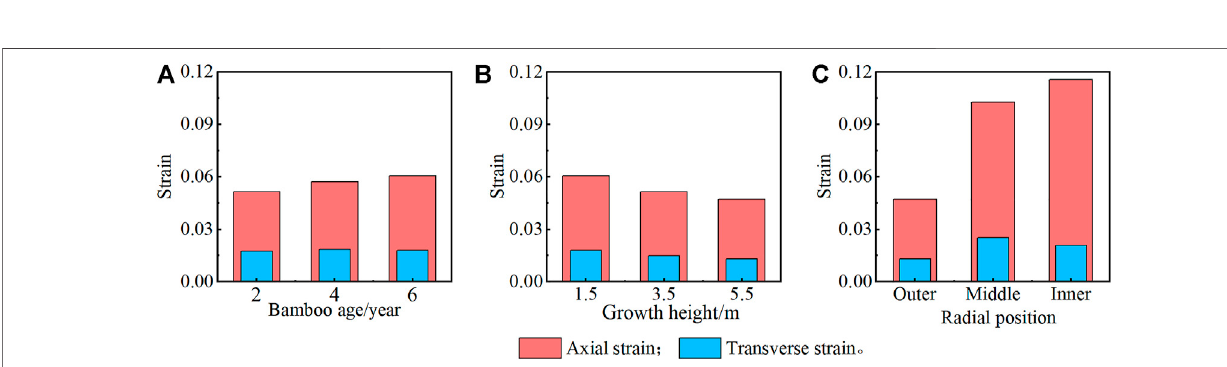
FIGURE 7 | Relationship between bamboo deformation: (A) Bamboo age; (B) Height; (C) Radial position.